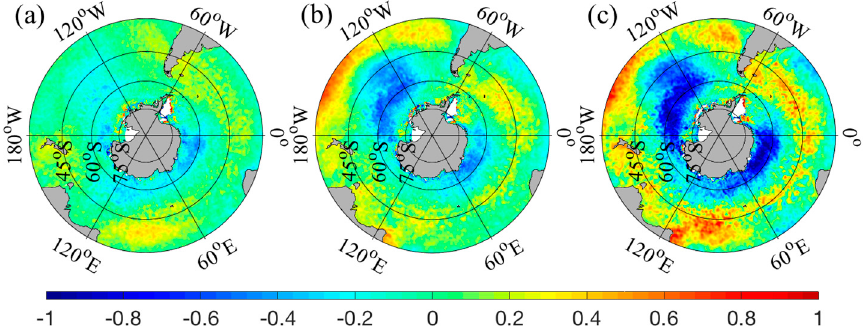
Figure 3. Monthly mean standardized sea surface temperature (SST) anomalies (°C) during ( a ) positive Antarctic Oscillation (AAO) and neutral Southern Oscillation (SO) months, ( b ) neutral AAO and positive SO months, and ( c ) both positive AAO and SO months. In each instance, a positive (negative) index is de fi ned as greater (less) than 0.5 ( − 0.5) and neutral between − 0.5 to 0.5. A comparison of monthly and yearly averaged standardized SST anomalies (Figure 4) mark